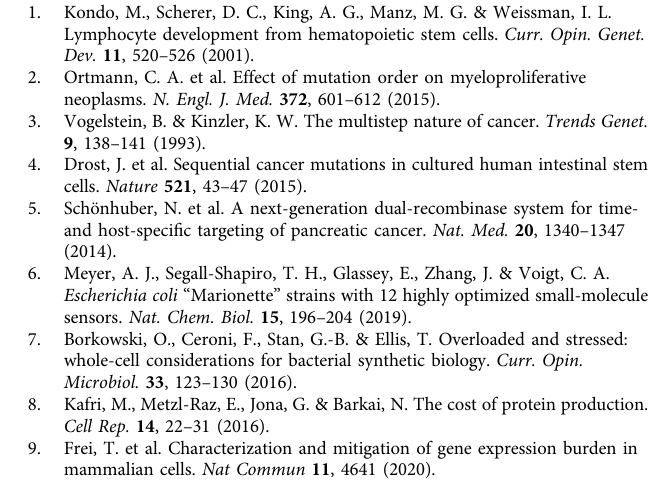
Reporting summary . Further information on research design is available in the Nature Research Reporting Summary linked to this article. Data availability The plasmids are available upon request. The NGS data is deposited in Short Read Archive (SRA) PRJNA680170: SRR13106981, SRR13106982. The custom codes used for analyzing NGS data are deposited in github: https://github.com/tackhoonkim/GPC- NatComms2021. Source data are provided with this